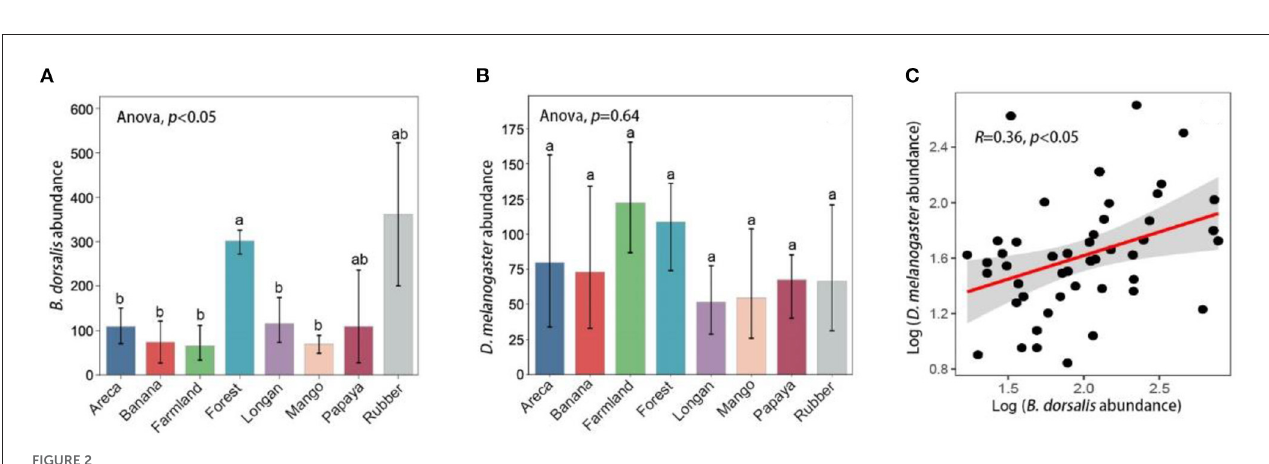
FIGURE2 Species abundance differences among habitats. (A) Indicates Bactrocera dorsalis abundance, (B) indicates Drosophila melanogaster abundance, and different lowercase letters on the histogram indicate significant differences. (C) Indicates the correlation between B. dorsalis and D. melanogaster abundance by correlation